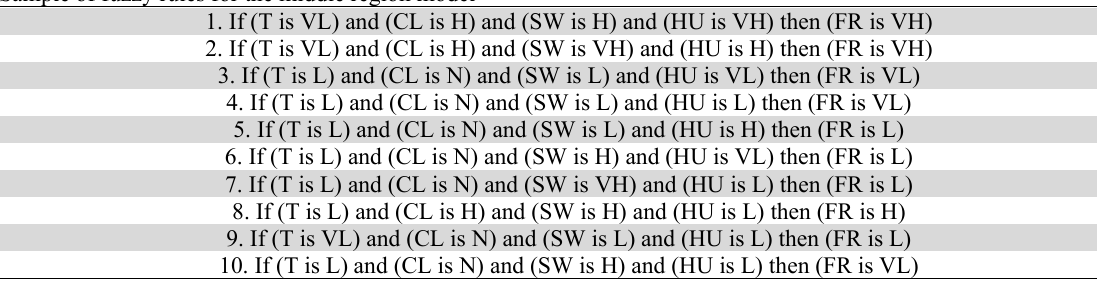
Fig. 9. Membership functions related to wind speed (SW) – middle model